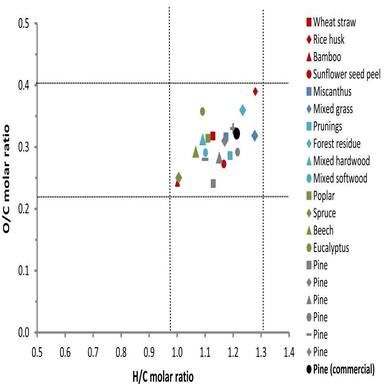
Van Krevelen plot of the PL used in this study, labeled as Pine (commercial), and literature data of other PLs from various biomass sources.